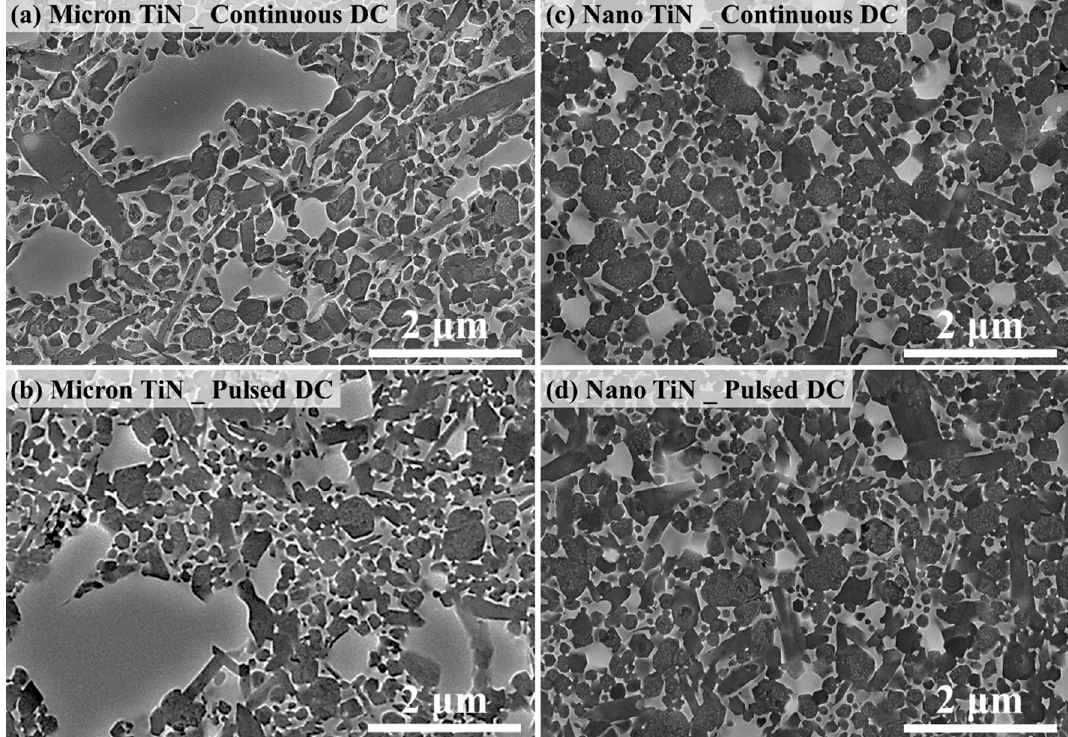
Figure 5. Microstructural images of Si 3 N 4 -20 vol % TiN samples with ( a , b ) micron- or ( c , d ) nano-TiN particles, respectively sintered under ( a , c ) continuous current mode or ( b , d ) pulsed mode at 1800 °C for 30 s.